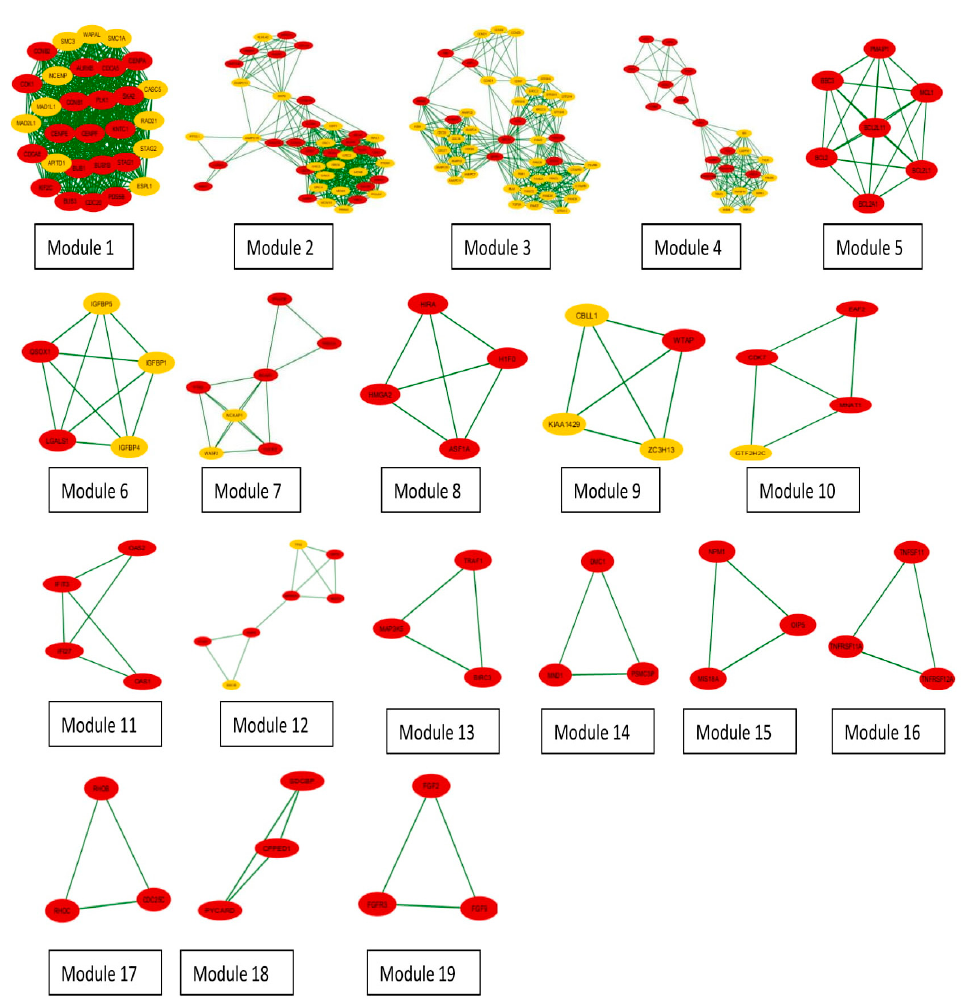
Figure 8. Network modules: red circles show the seed proteins and yellow circles are the connectors.